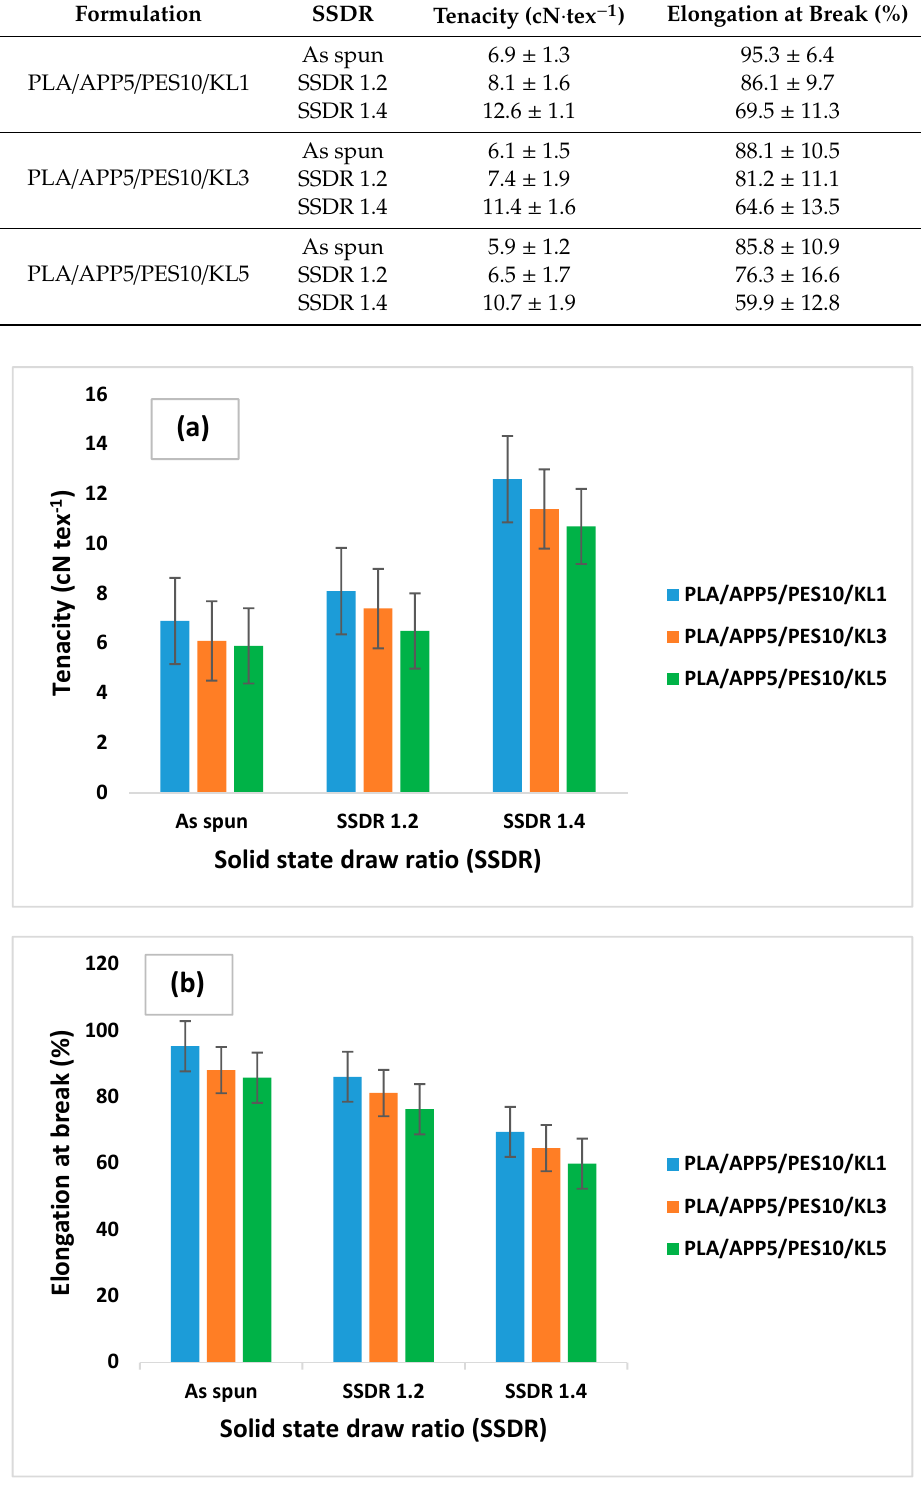
Figure 3. Tenacity ( a ) and elongation at break ( b ) of PLA/APP/PES/KL bicomponent fibers.